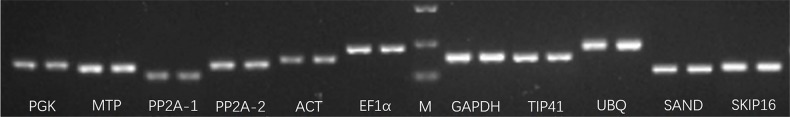
Agarose gel electrophoresis of amplicons of eleven candidate reference genes.Marker (M) from top to bottom: 500, 250 and 100 bp. The primer pairs in each separation are ordered from left to right as PGK, MTP, PP2A-1, PP2A-2, ACT, EF1α, GAPDH, TIP41, UBQ, SAND, SKIP16 (two technical replicates).